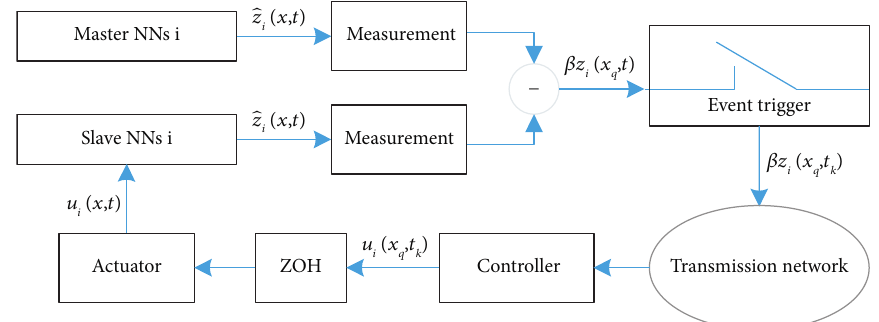
Figure 1: The i th event-triggered controller structure of the i th master-slave